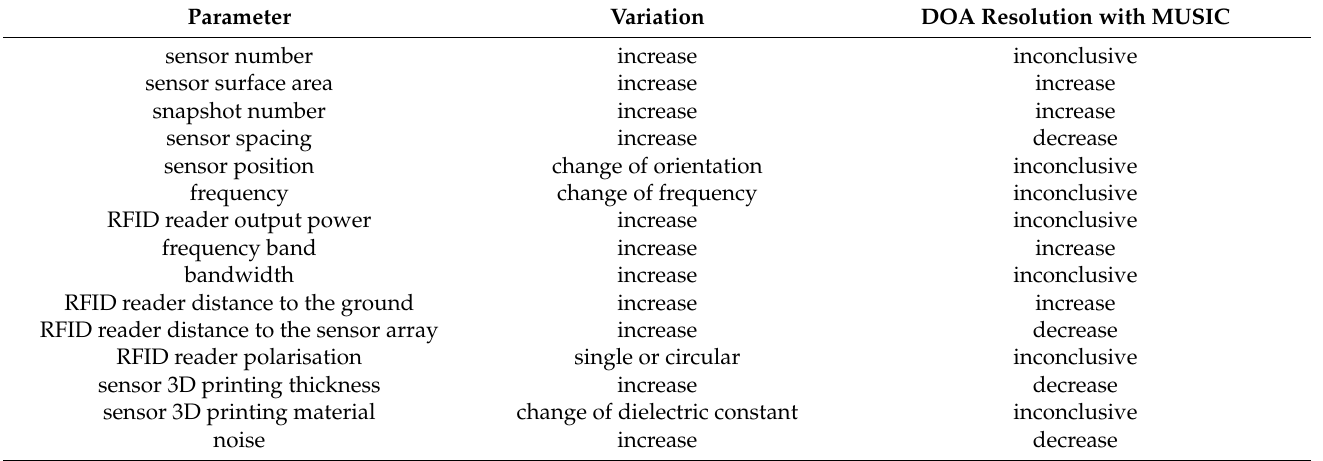
Table 3. Parameters affecting the test